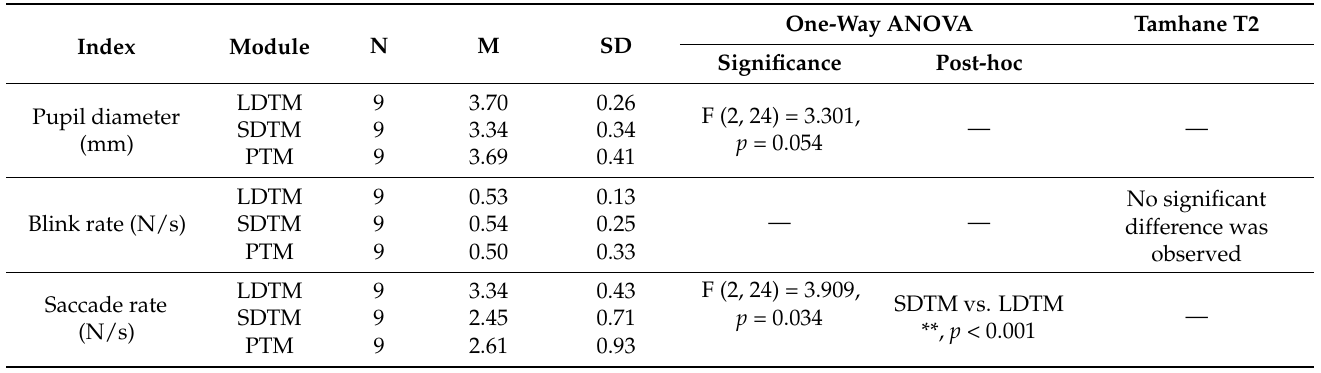
Table 4. The results and comparisons of gaze features.